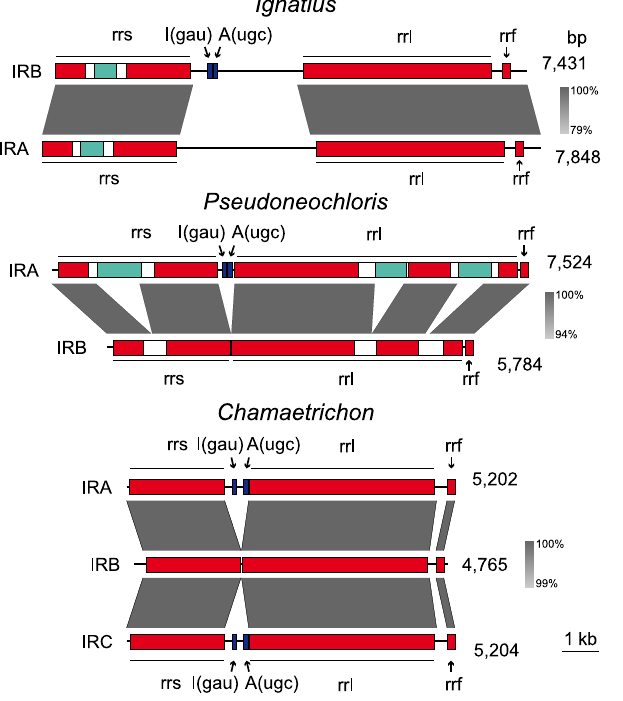
Figure 5. Comparison of IR sequences in the ulvophycean chloroplast genomes carrying non-identical IR copies. Regions displaying similar sequences are connected by shaded areas, with sequence identity denoted by the grey scale. Red and dark blue boxes represent coding regions of rRNA and tRNA genes, respectively; turquoise and white boxes represent ORFs and noncoding regions within introns, respectively.